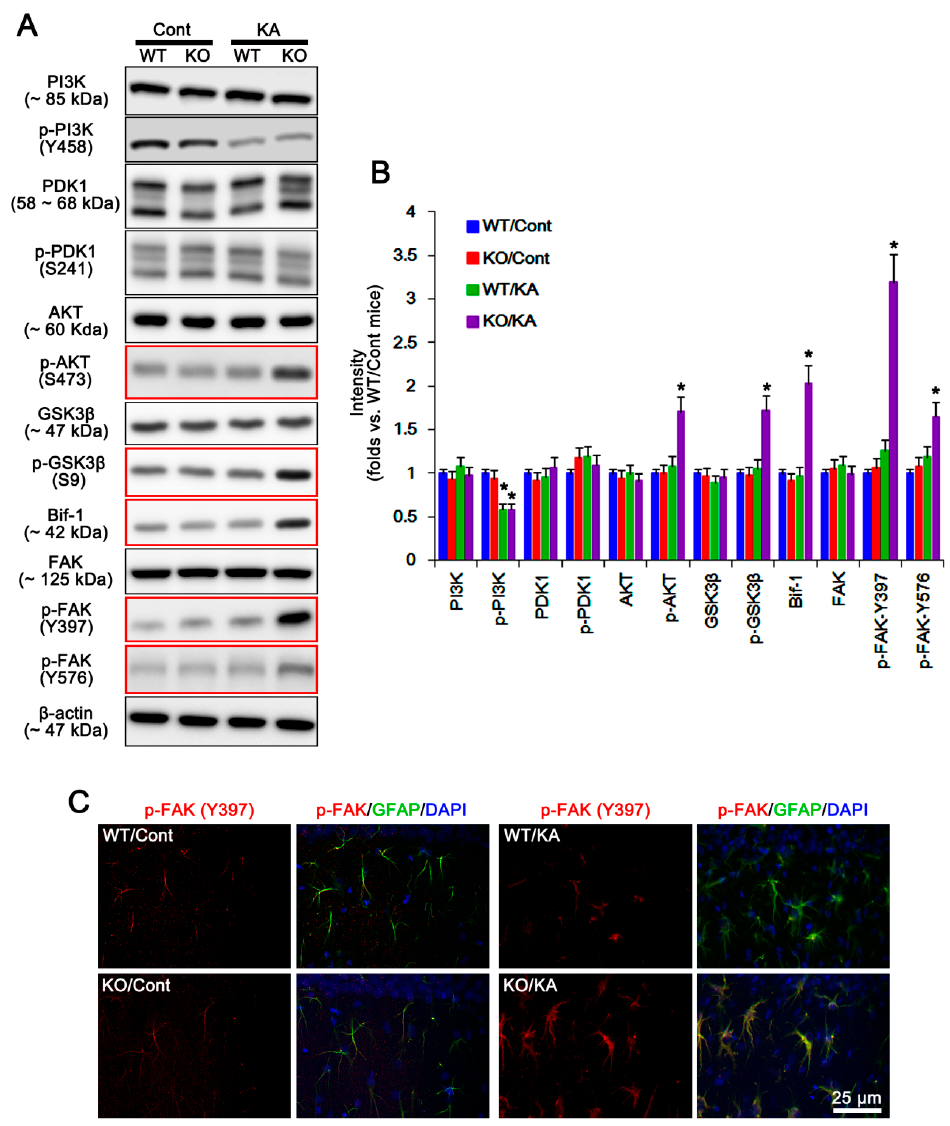
Figure 4. E ff ects of P2X7R deletion on expressions and phosphorylations of phosphatidylinositol-4,5-bisphosphate 3-kinase (PI3K), phosphoinositide-dependent kinase-1 (PDK1), AKT, GSK3 β , Bif-1, and FAK in isolated astrocytes following KA injection. KA increases p-AKT-S473, p-GSK3 β -S9, Bif-1, p-FAK-Y397, and p-FAK-Y576 levels in KO astrocytes 7 days after KA injection (red box). ( A ) Representative Western blot of expressions and phosphorylations of PI3K, PDK1, AKT, GSK3 β , Bif-1, and FAK. Cont, control animals; KA, KA-injected animals. ( B ) Quantifications of expressions and phosphorylations of PI3K, PDK1, AKT, GSK3 β , Bif-1, and FAK following KA injection (mean ± SEM; * p < 0.05 vs. control WT astrocytes; n = 7, respectively). ( C ) Effect of P2X7R deletion on p-FAK-Y397 level in the hippocampal astrocytes. As compared to WT mice, p-FAK-Y397 level is higher in KO mice 7 days after KA injection.